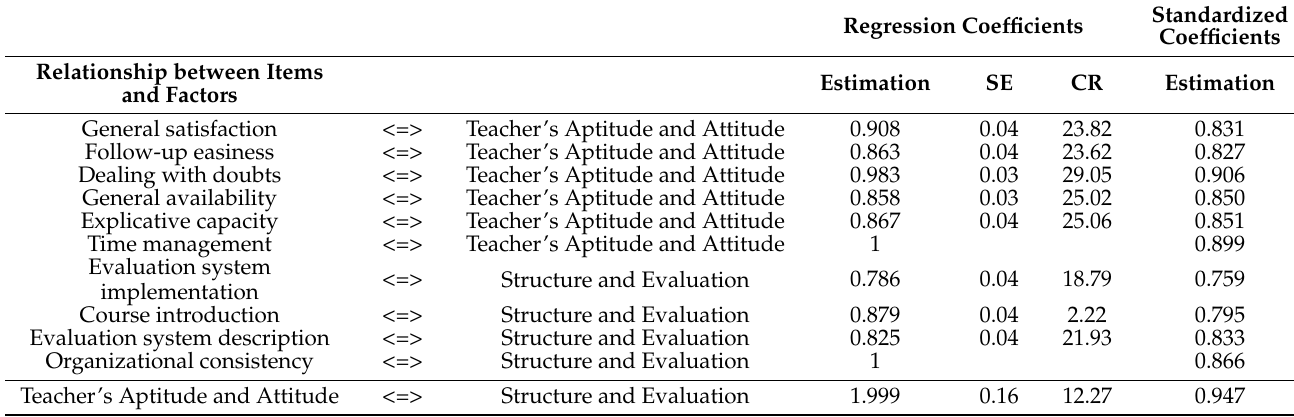
Table 3. Regression coefficients and standardized regression coefficients between items and